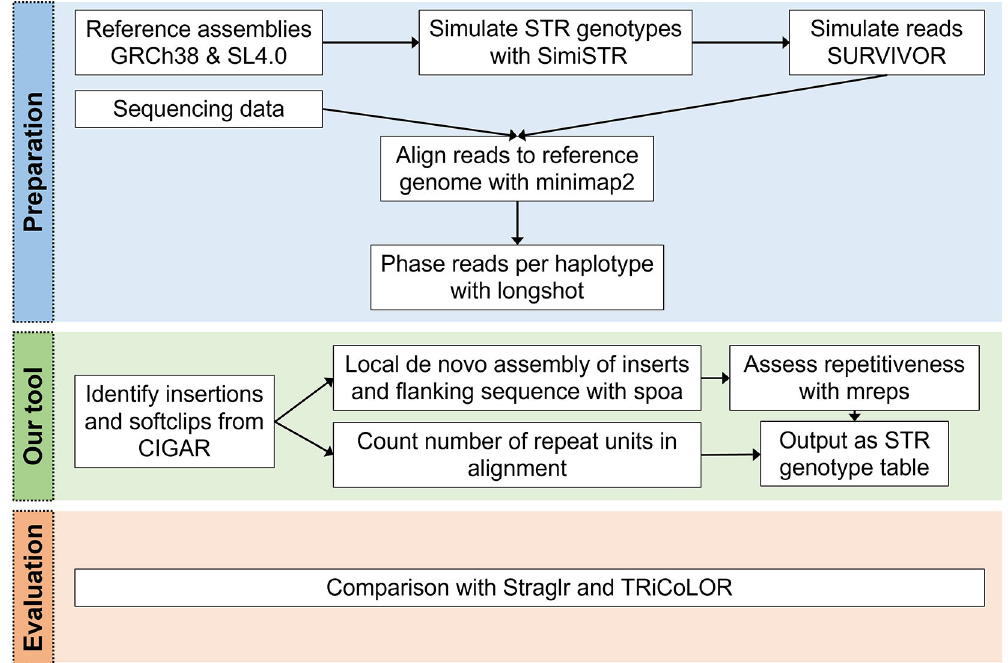
Figure 1. STRdust workflow. During the preparation phase, reads (either simulated or sequenced) are aligned to the corresponding reference genome with Minimap2 32 and the mapped reads are then phased using longshot. Next, STRdust identifies insertions and soft-clips from the Concise Idiosyncratic Gapped Alignment Report (CIGAR) string which identify regions of possible short tandem repeats (STR) expansion. These regions are further analyzed by performing de novo assembly using spoa and assessing the repetitiveness of the region with mreps. STRdust outputs the STR genotype as a tab separated table for further analysis. We evaluated STRdust by comparing